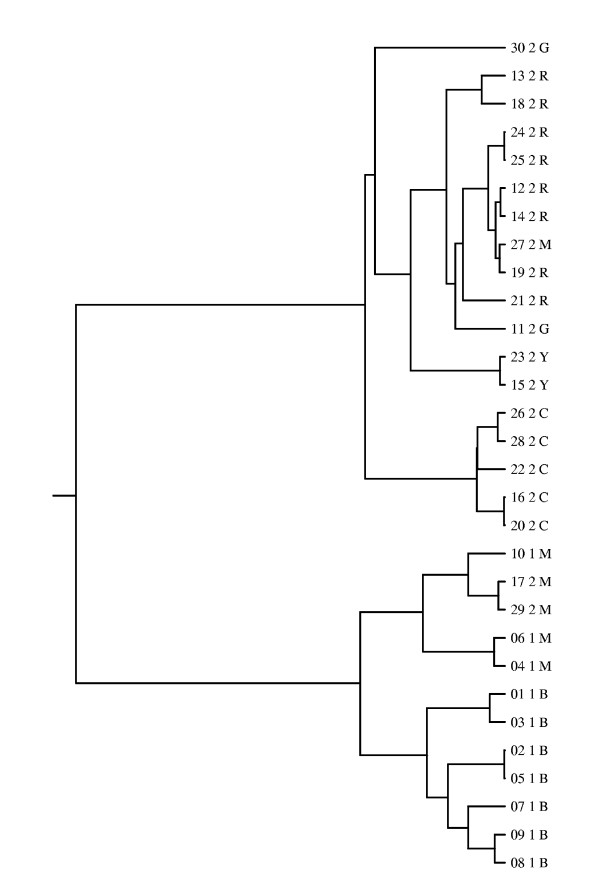
Evolutionary history for the second fragment in the coalescent simulation. Evolutionary tree for the second fragment in the coalescent simulation. The leaf nodes correspond to the strains in the data set, and are labelled as XX Y Z, where XX is strain index, Y is the deme to which the strain belonged in the simulation and Z is the cluster label for the strain from BAPS analysis. The clusters are labelled by different colors as follows: R = red, G = green, B = blue, Y = yellow, M = magenta, C = cyan.